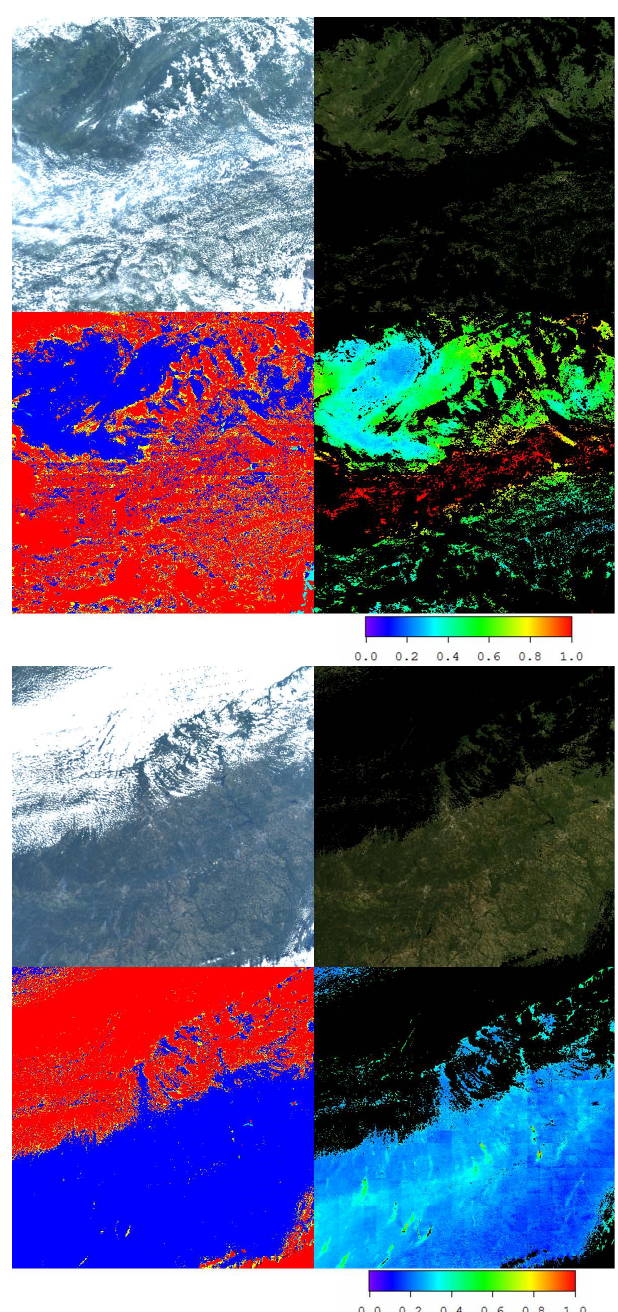
Fig. 5. (a) Illustration of a large-scale MAIAC algorithm perfor- mance during wild fires of 2003 in Georgia (USA) on day 235 (a) and 274 (b) . The images show MODIS Terra TOA data, MAIAC RGB BRF, cloud mask and AOT 0 . 47 for 600km tiles. The cloud mask color coding is described in caption of Fig. 4. (b) The same as Fig. 5a but for day 274 of